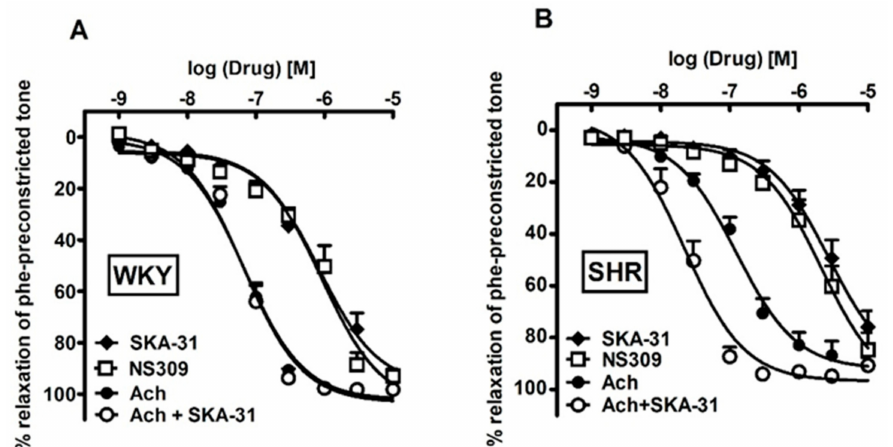
Figure 7. Vasorelaxant e ff ects of SKA-31, NS309, Ach and the interaction of SKA-31 with Ach in small mesenteric arteries from normotensive Wistar Kyoto (WKY) ( A ) and spontaneously hypertensive (SHR) rats ( B ). Results are expressed as a percentage of relaxation of the isometric contraction induced by phenylephrine (Phe). Mean ± SEM of n = 5–12 animals for each curve. In a few cases, the SEM is smaller than or equal to the size of